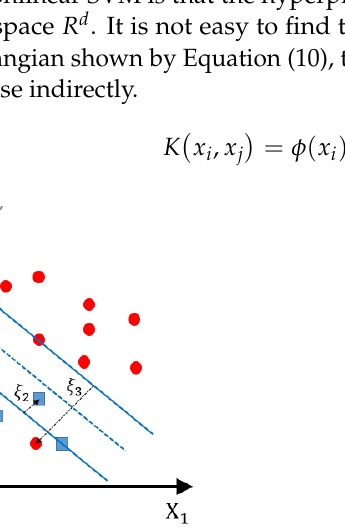
Table 1. Some popular kernel